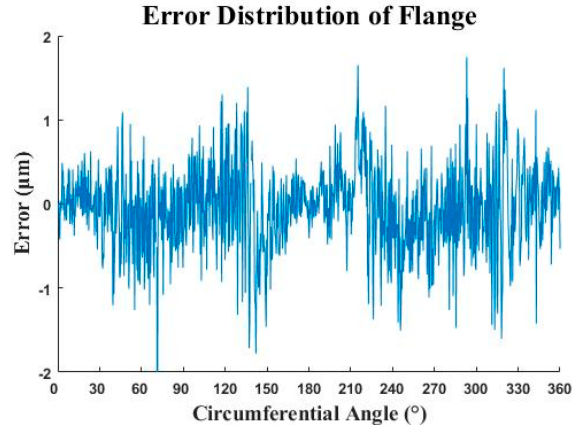
Figure 11. The error distribution of flange.